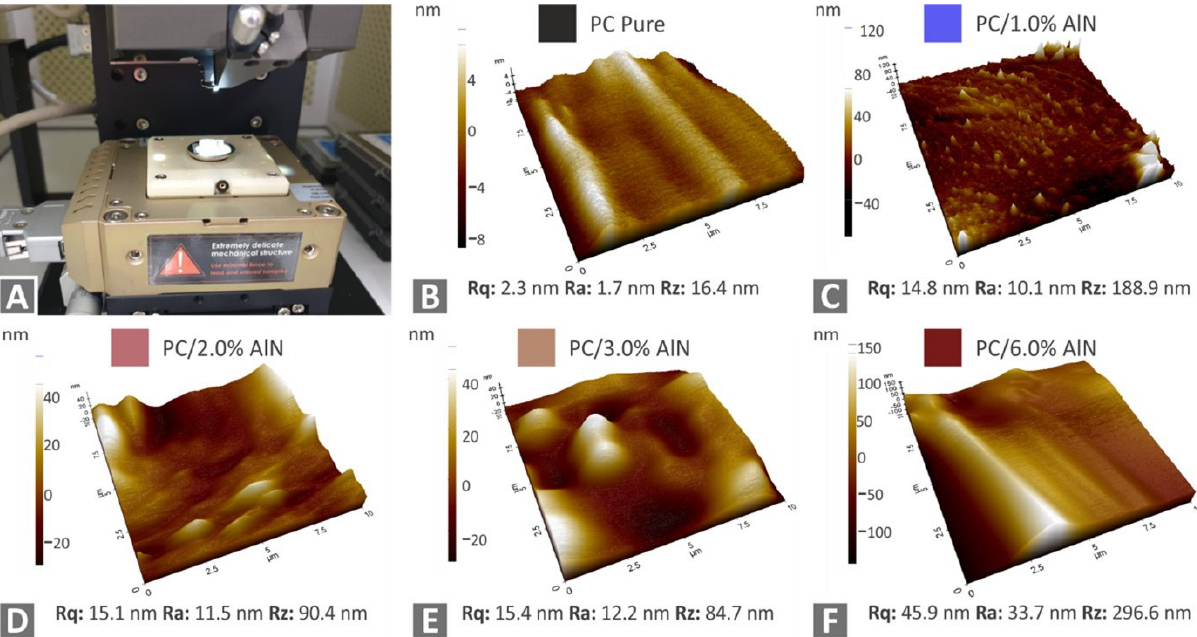
Figure 7. AFM measurements for the study of surface characteristics of tested filaments: ( A ) AFM instrument illustration; images for ( B ) pure PC ( C ) PC/1 wt.% AlN ( D ) PC/2 wt.% AlN, ( E ) PC/3 wt.% AlN, and ( F ) PC/6 wt.% AlN.